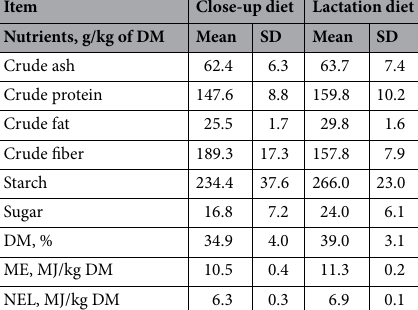
Table 1. Nutrient composition and energy content of the dried close-up and lactation diet fed during the preference tests. DM dry matter.